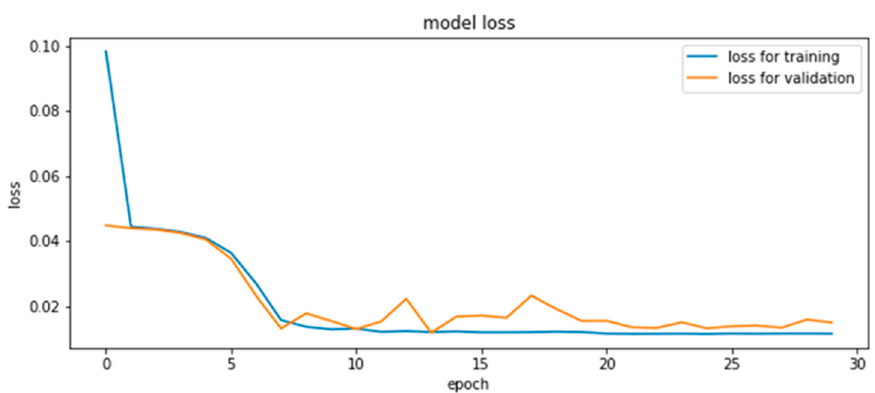
Figure 8. Transition of the training error and validation error in RMSE.